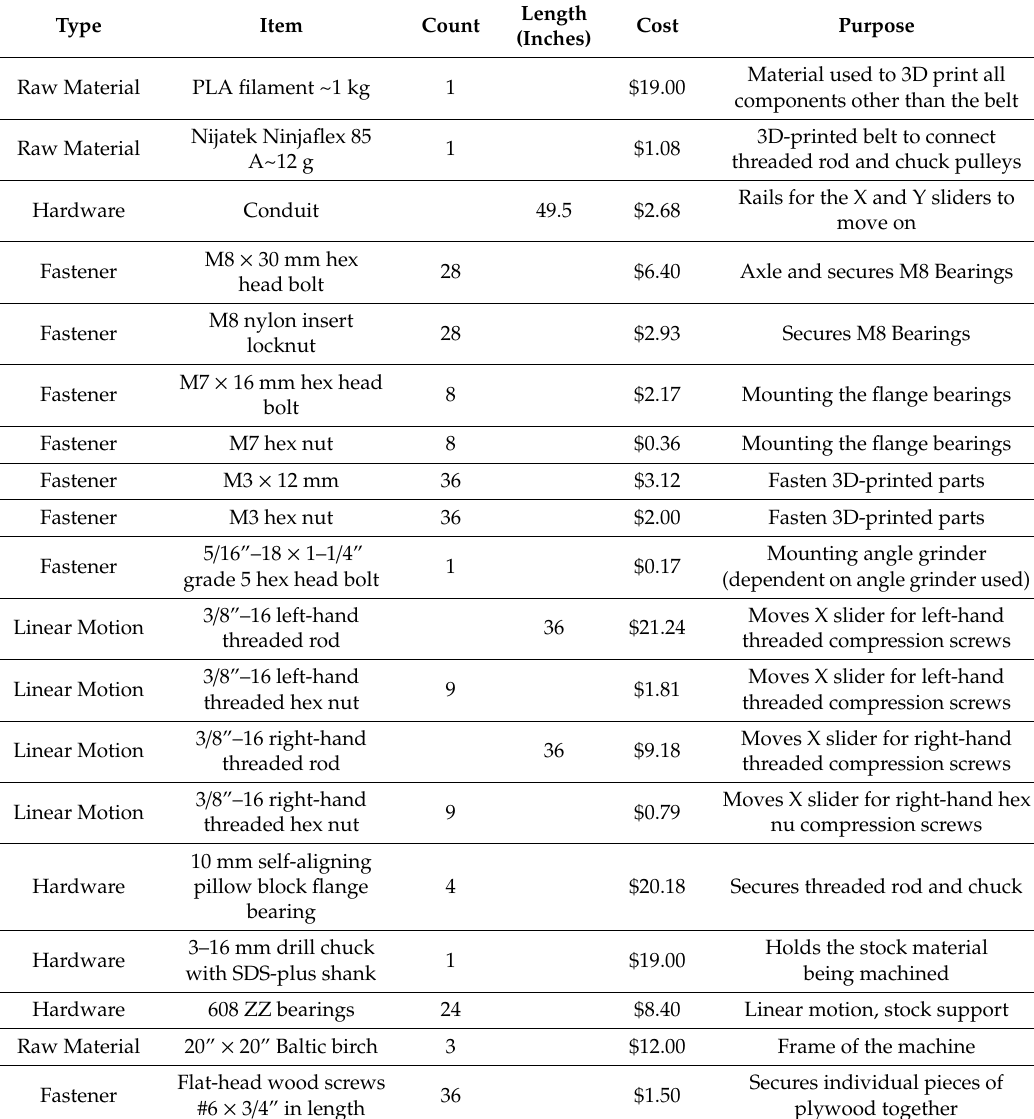
Table 1. Bill of Materials (BOM) for the Open-Source Grinding Machine for Compression Screw